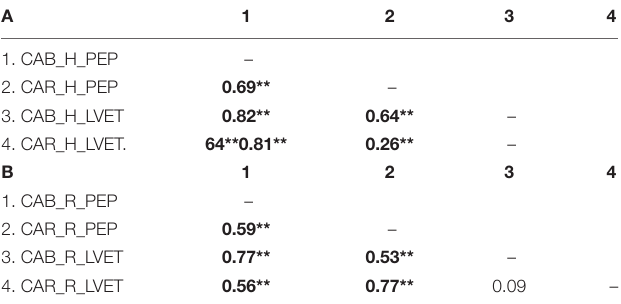
Table 3A shows zero-order correlations between cardiac autonomic balance (CAB) and cardiac autonomic regulation (CAR) variables that were calculated using high frequency heart rate variability (denoted as “H”) and pre-ejection period (PEP) or left ventricular ejection time (LVET), respectively. Table 3B shows CAB and CAR calculated using the root mean square of successive differences (denoted as “R”) and pre-ejection period (PEP) or left ventricular ejection time (LVET), respectively. Statistically significant correlations are bolded, **p <